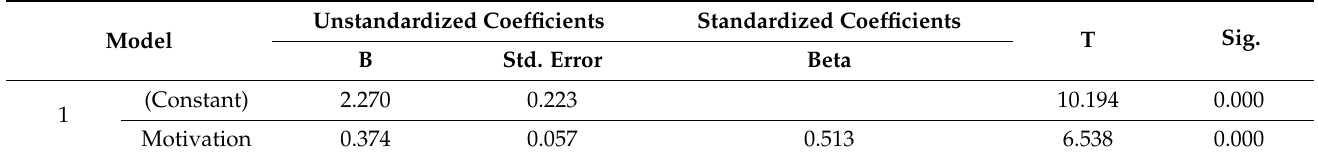
Table 3. Impact of motivational factors on job performance.